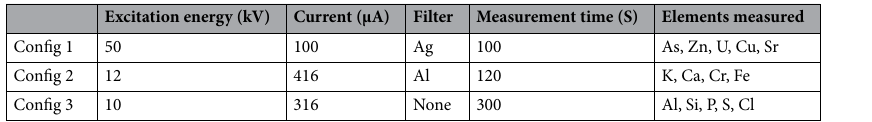
Table 3. The measurement parameters of the three